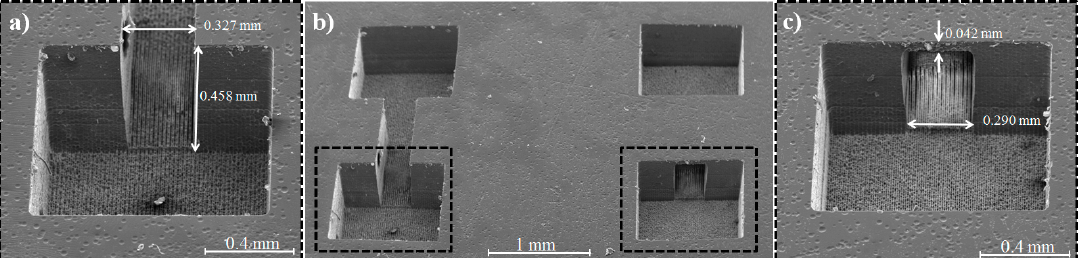
Figure 5. SEM images of structures fabricated by VIS-PLAE using a ps laser at power of 500 mW and a design of 10 μ m interline spaces, at two different scanning speeds: 0.1 mm/s ( a , b ) and 0.9 mm/s ( b , c ). The laser irradiation was carried out with two-layer configuration: on the surface (first layer) and at 250 μ m depth (second layer).